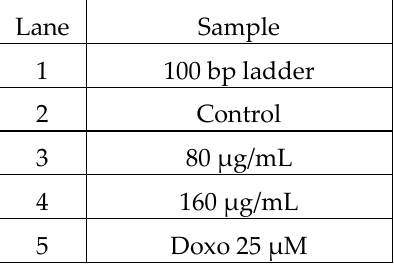
Figure 11. Sample loading order.